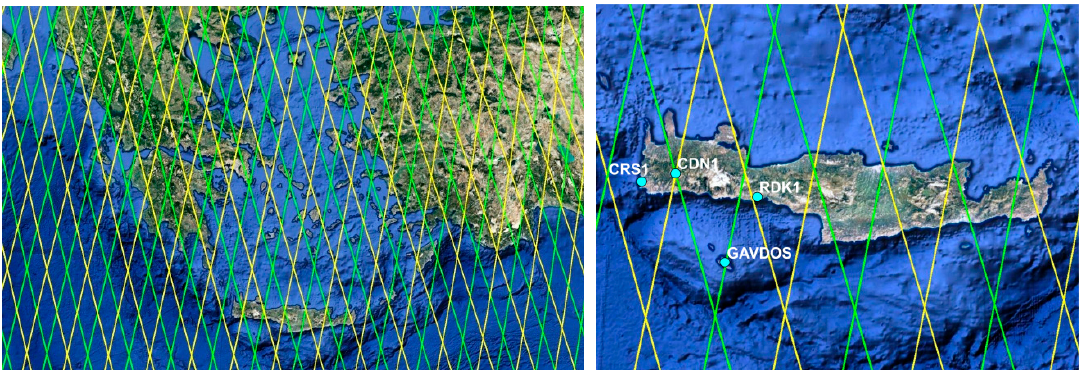
Figure 1. Sentinel-3A (green) and Sentinel-3B (yellow) ground tracks over Greece ( left ) and the island of Crete ( right ). The location of several calibration and validation (Cal/Val) sites in west Crete, Greece are shown in the right image.